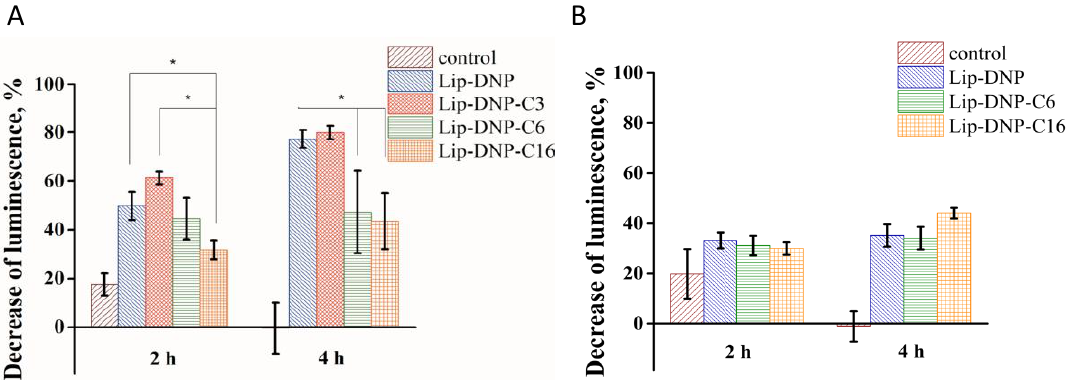
Figure 5. Decrease in luminescence signal from a maximum at the beginning of the D-luciferin– luciferase reaction (30 min point, Supplementary Figure S6) during 2 h and 4 h without (control) and after addition of 2,4-DNP (compound 1 ), 2,4-DNP-C16 (compound 2 ), 2,4-DNP-C6 (compound 3 ), 2,4-DNP-C3 (compound 4 ) loaded into liposomes, composed of ( A ) eggPC/DSPE-PEG-OMe (95/5 molar ratio) and ( B ) DSPC/DSPE-PEG-OMe (95/5 molar ratio) lipids. D-Luciferin–luciferase coupled assay was provided using 4T1-Luc cell line in RPMI 1640 (10% FBS) at 37 °C. The total D-luciferin concentration was 150 µg/ml; 2,4-DNP (compound 1 ), 2,4-DNP-C16 (compound 2 ), 2,4-DNP-C6 (compound 3 ), 2,4-DNP-C16 (compound 4 ) concentrations were 200 µ M. The samples with untreated cells (only D-luciferin addition) were set as control. Data are presented as mean ± StD ( n = 6 ( A ), n = 5 ( B )), * p < 0.05.